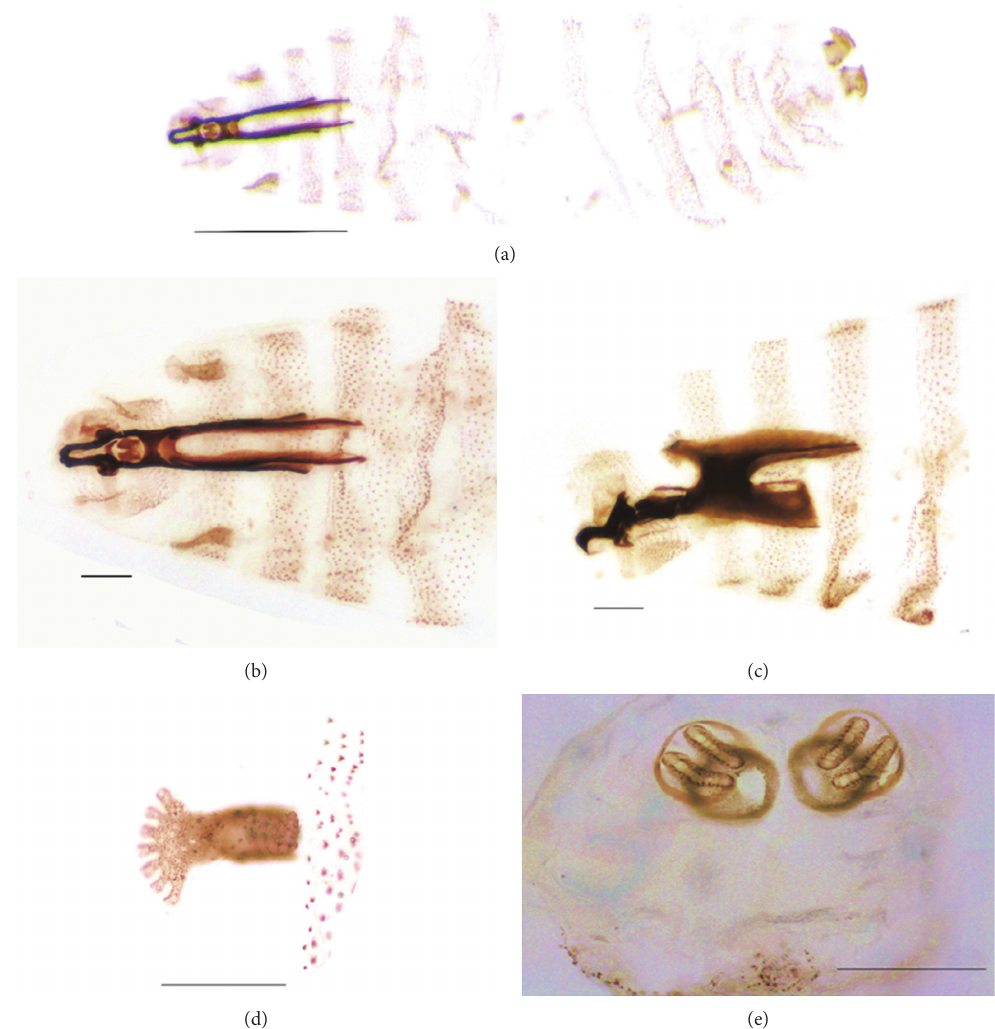
Figure 2: Lucilia sericata . Second stage larva. (a) Specimen, dorsal view (a) � 2.5x. (b) Cephaloskeleton, dorsal view. (c) Cephaloskeleton, lateral view ((b and c) � 4x). (d) Anterior stigma. (e) Posterior stigmata plates ((d and e) � 10x). Scales: (a) � 0.5mm; (b)–(e) �